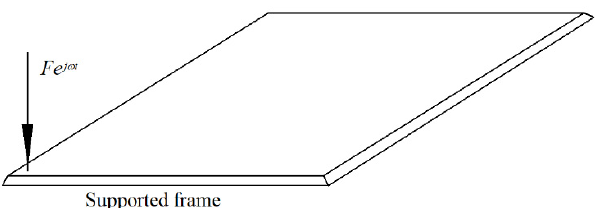
Figure 2. A membrane connected to a supported frame excited by a point force.